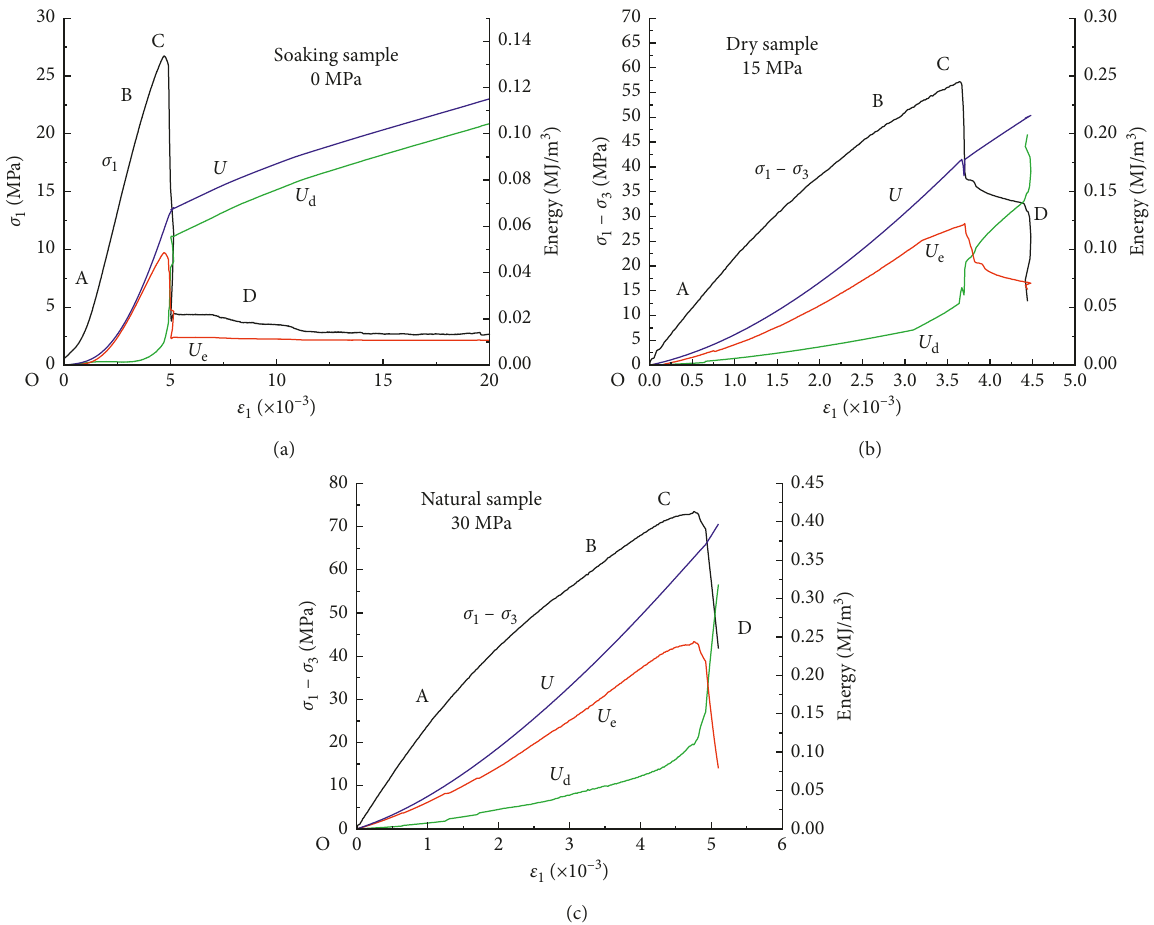
Figure 4: Relation curves of stress and energy with strain for mudstone samples under different moisture contents and confining